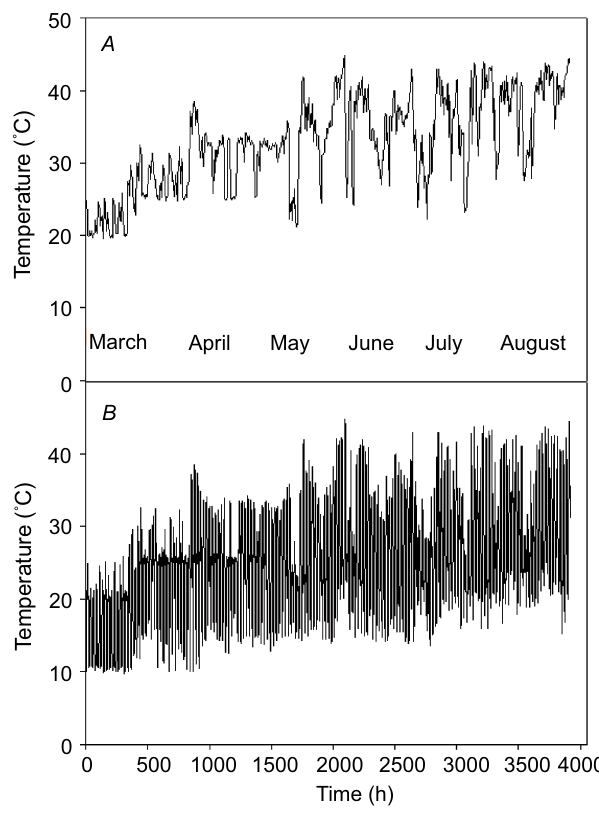
Figure 1. Time course of temperatures in the greenhouses during the experimental period (March 1 through August 15). ( A ) Postmeridian (hour) pattern between 13:00 and 16:00; ( B ) Diel (hour) pattern between 0:00 and